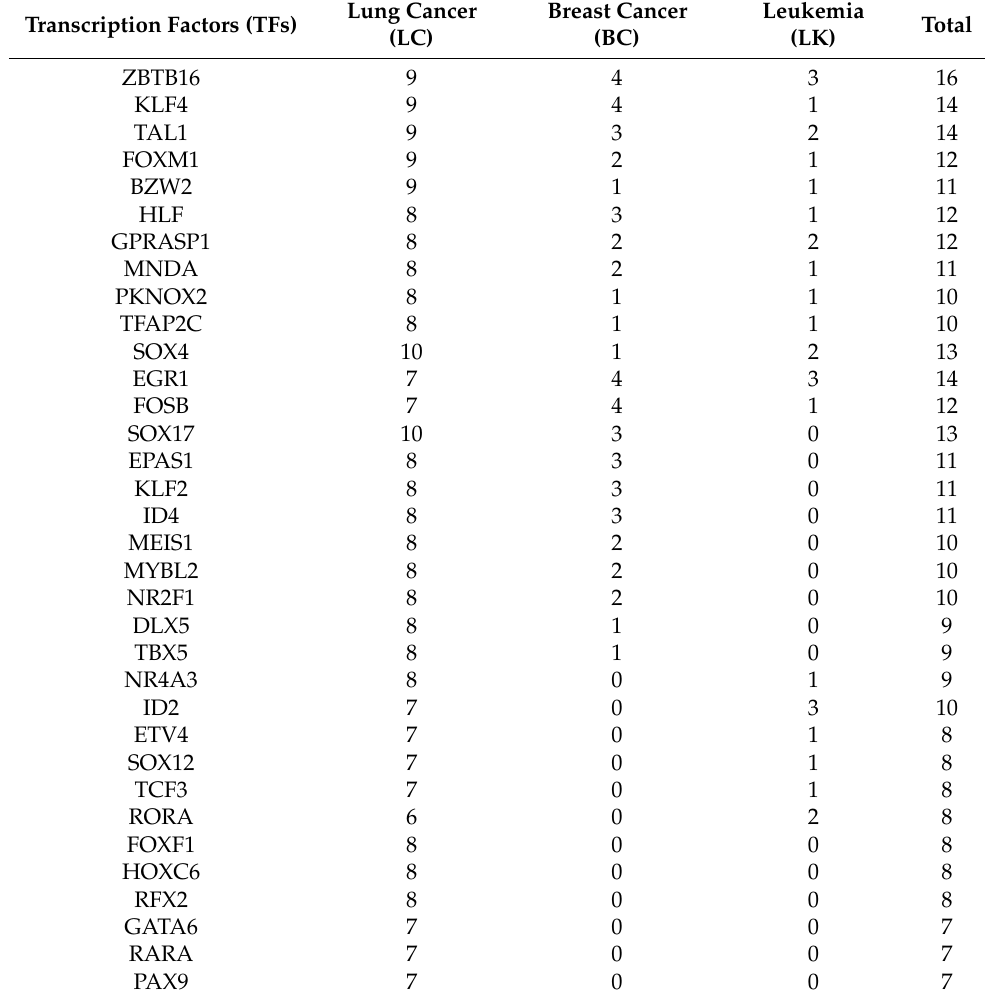
(Figure 2), nine deregulated winning TFs in common between lung cancer and breast cancer (Figure 3), and six deregulated winning TFs in common between lung cancer and leukemia (Figure 4). Additionally, there are six deregulated unique LC winning TFs (Figure 5). Table 2. List of winning transcription factors in common among the three types of cancer and unique to lung cancer. Number of deregulated lung cancer, breast cancer, and leukemia datasets. Lung Transcription Factors (TFs)